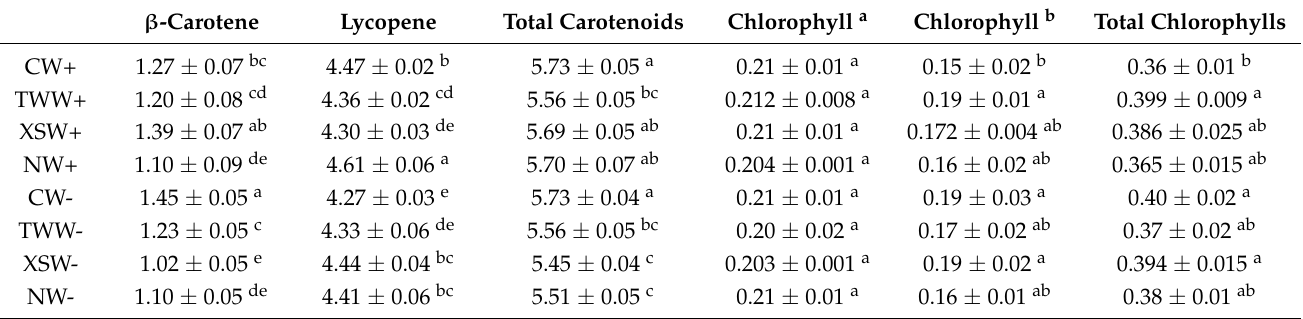
Table 3. Carotenoid and chlorophyll composition (mg/100 g dw) of tomato fruit in relation to irrigation regime and biostimulant treatment (mean ± SD, n = 3).